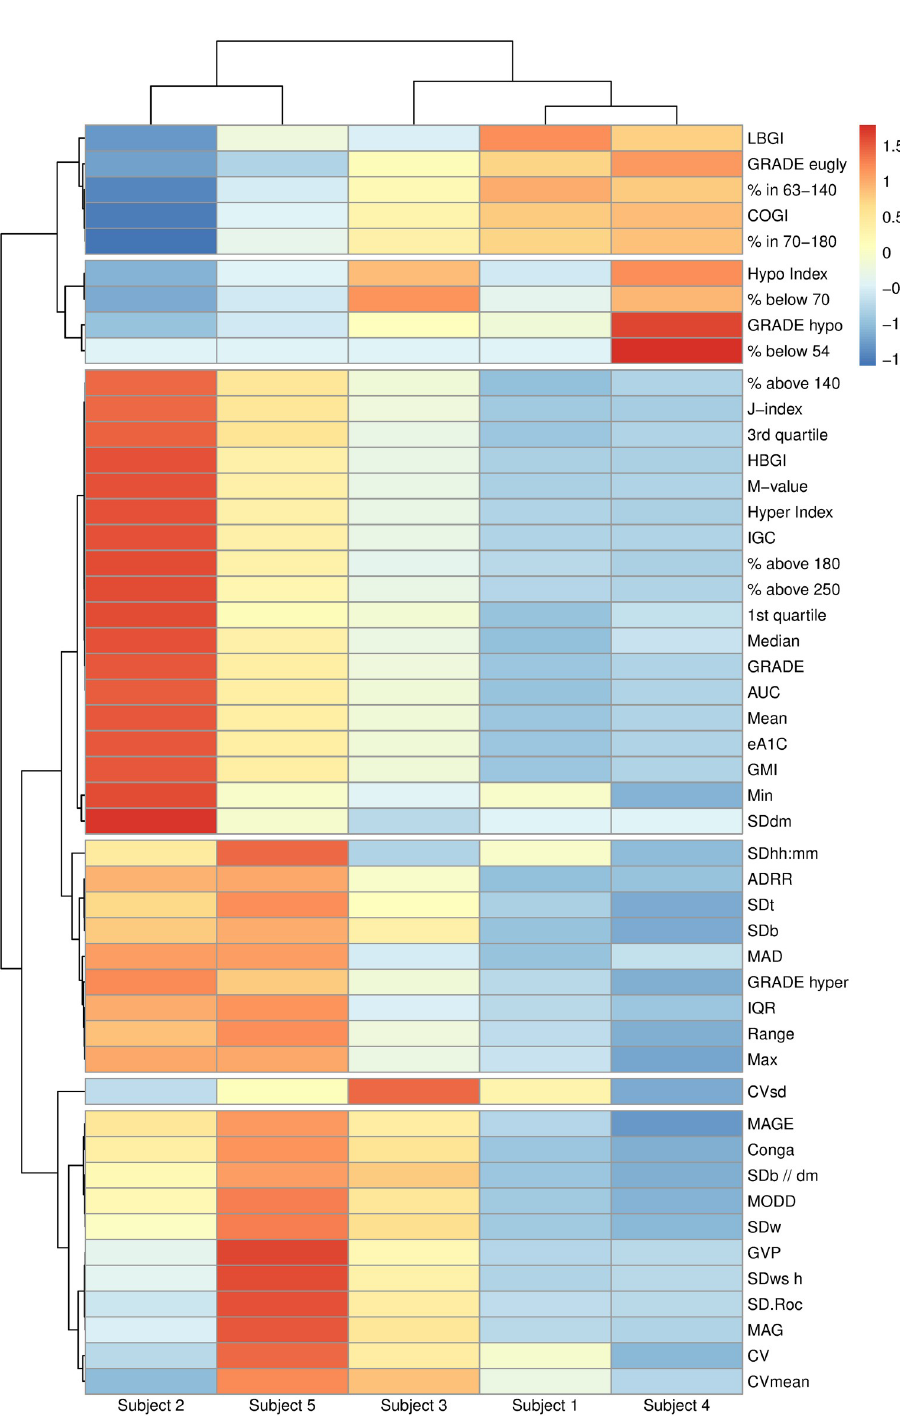
PLOS ONE | https://doi.org/10.1371/journal.pone.0248560 April 1,